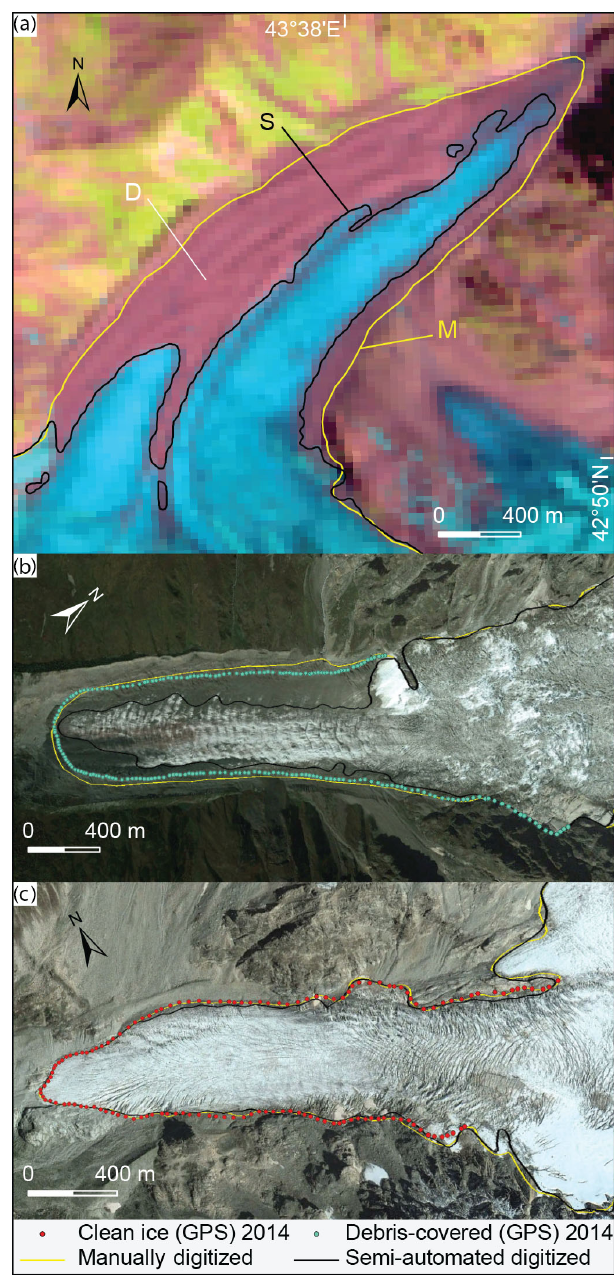
Figure 2. Mapping examples: (a) supra-glacial debris cover (D) as- sessment with comparison of different methods – fully manual map- ping (M) and semi-automated mapping (S; ratio TM 3/5 threshold ≥ 2 . 0 followed by manual improvement). The Landsat image from 6 August 1986 is shown in the background. Examples of glacier out- line accuracy assessment by GPS measurements: (b) Adishi Glacier and (c) Kirtisho Glacier. A Google Earth image from 19 Septem- ber 2011 is shown in the